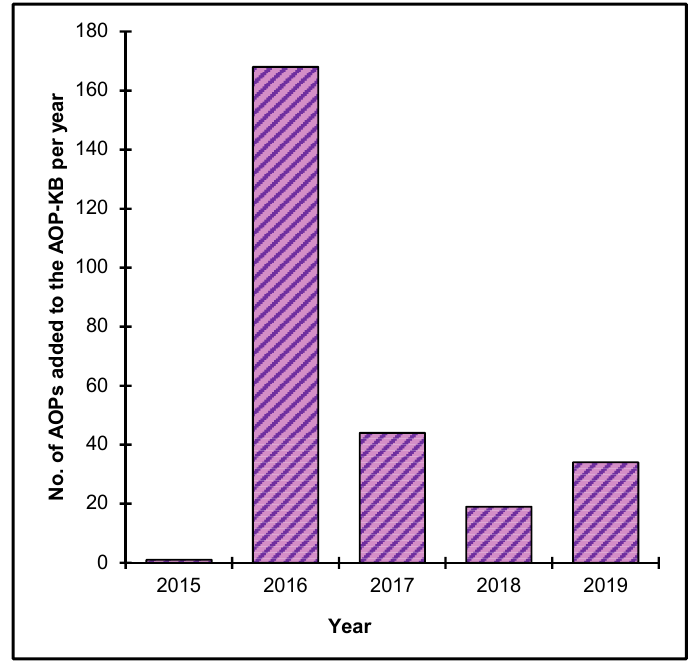
Figure 3. AOPs created in the AOP-KB from 2015–2019 (until May 22, 2020).